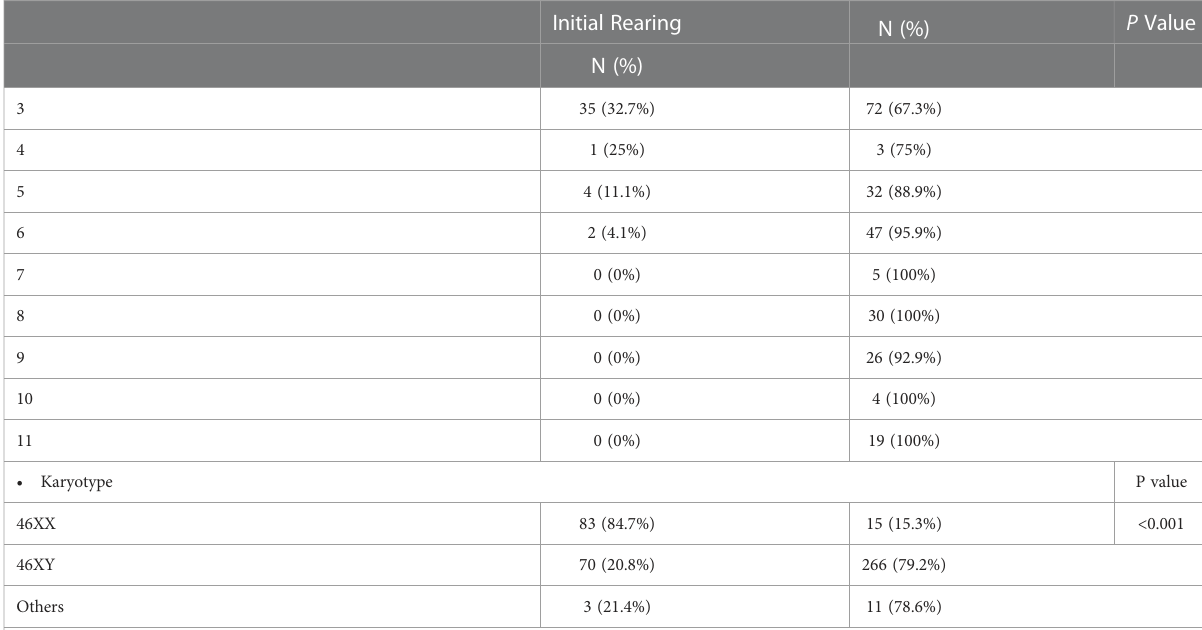
Comparison between hormonal pro fi le of patients with poor HCG response and those with normal HCG response